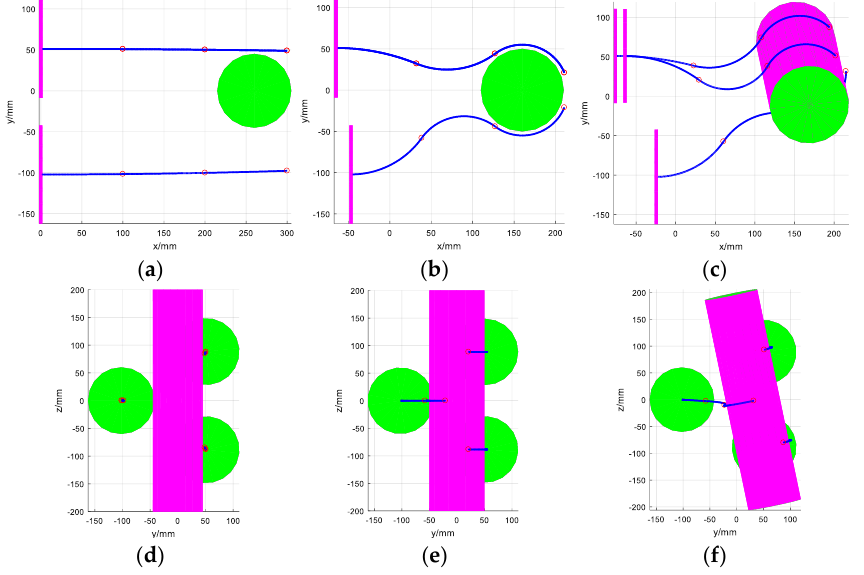
Figure 15. The process of grasping a cylinder using the multi-arm space robot. ( a ) Lateral view of initial state, ( b ) lateral view of middle state, ( c ) lateral view of final state, ( d ) top view of initial state, ( e ) top view of middle state, ( f ) top view of final state.